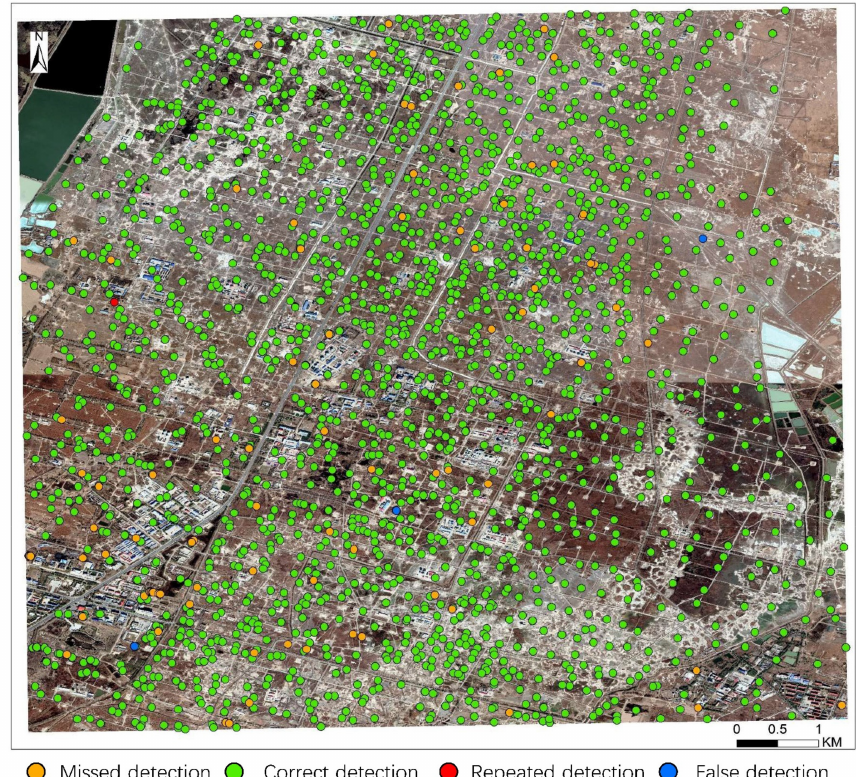
Figure 15. Detection result with the discarding edges set to 60.